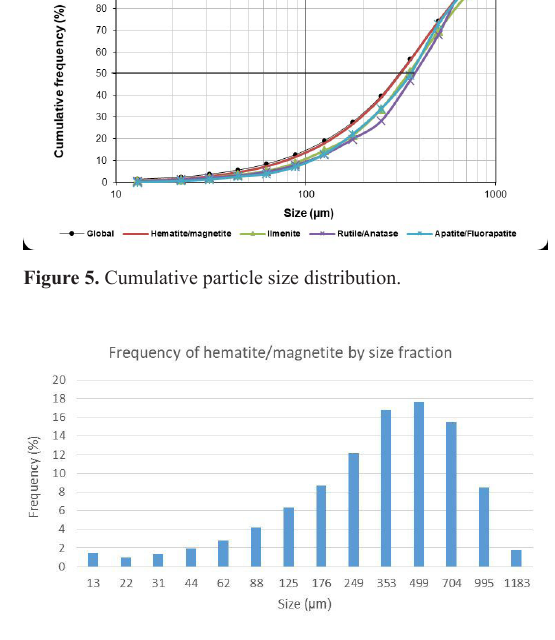
Figure 6. Particle size distribution of only hematite/magnetite by